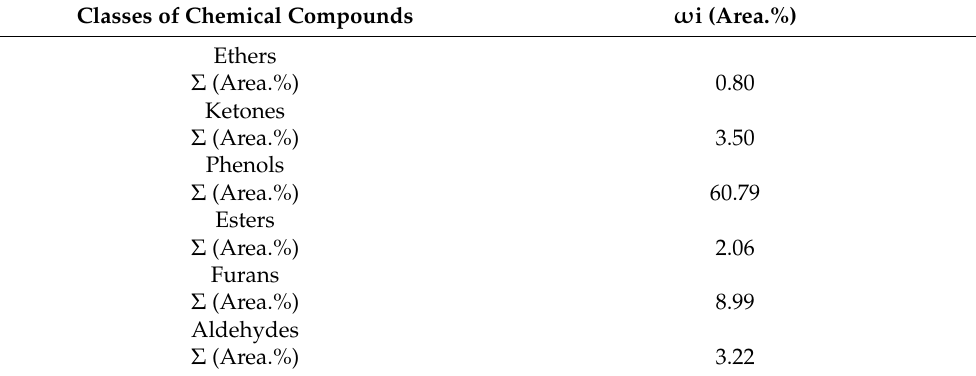
Table 12. Cont. Classes of Chemical